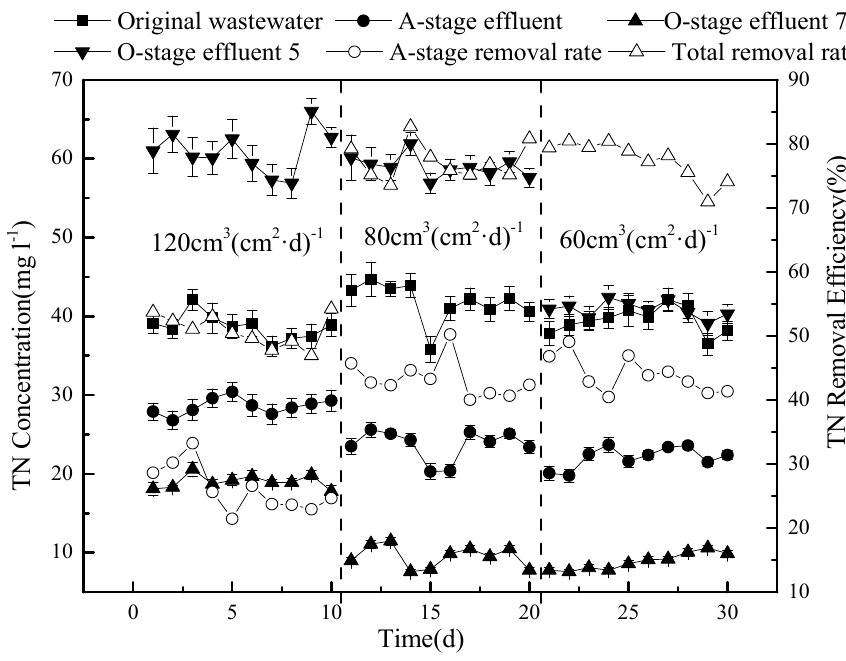
Figure 10. Variation in total nitrogen concentration under the three different hydraulic loads.